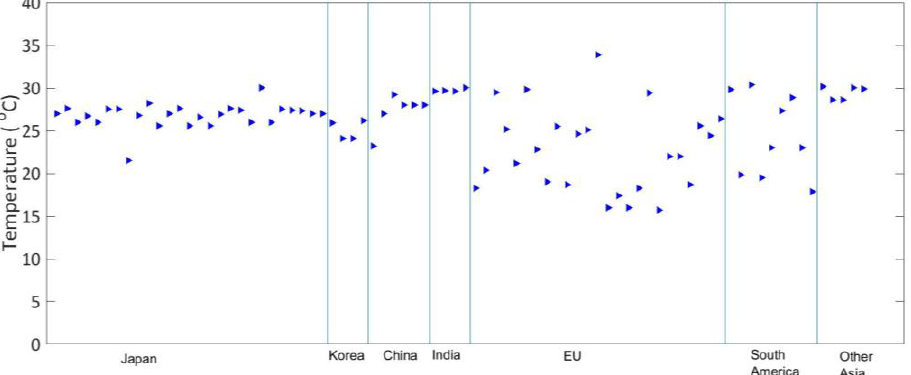
Energies 2017 , 10 , 2152 Figure 9. Maximum seawater temperatures around the world. Figure 9. Maximum seawater temperatures around the world.